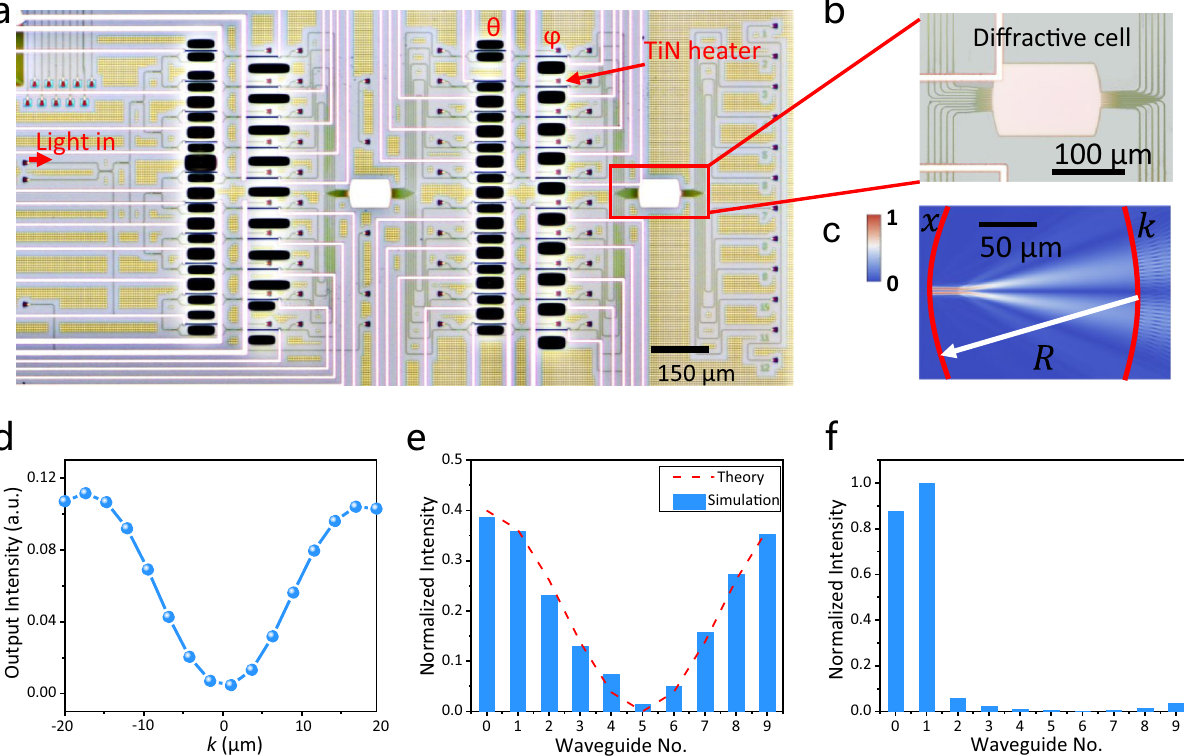
Fig. 2 Optical microscope photos and some simulation results. a The optical micrograph of the whole chip. b The optical micrograph of the diffractive cell. c Simulated electric fi eld distribution in the slab waveguide region. d Simulated output amplitude distribution along the output waveguide plane. e Simulated normalized intensity of ten channels after ODFT operation. f Simulated normalized retrieved intensity information of ten channels.